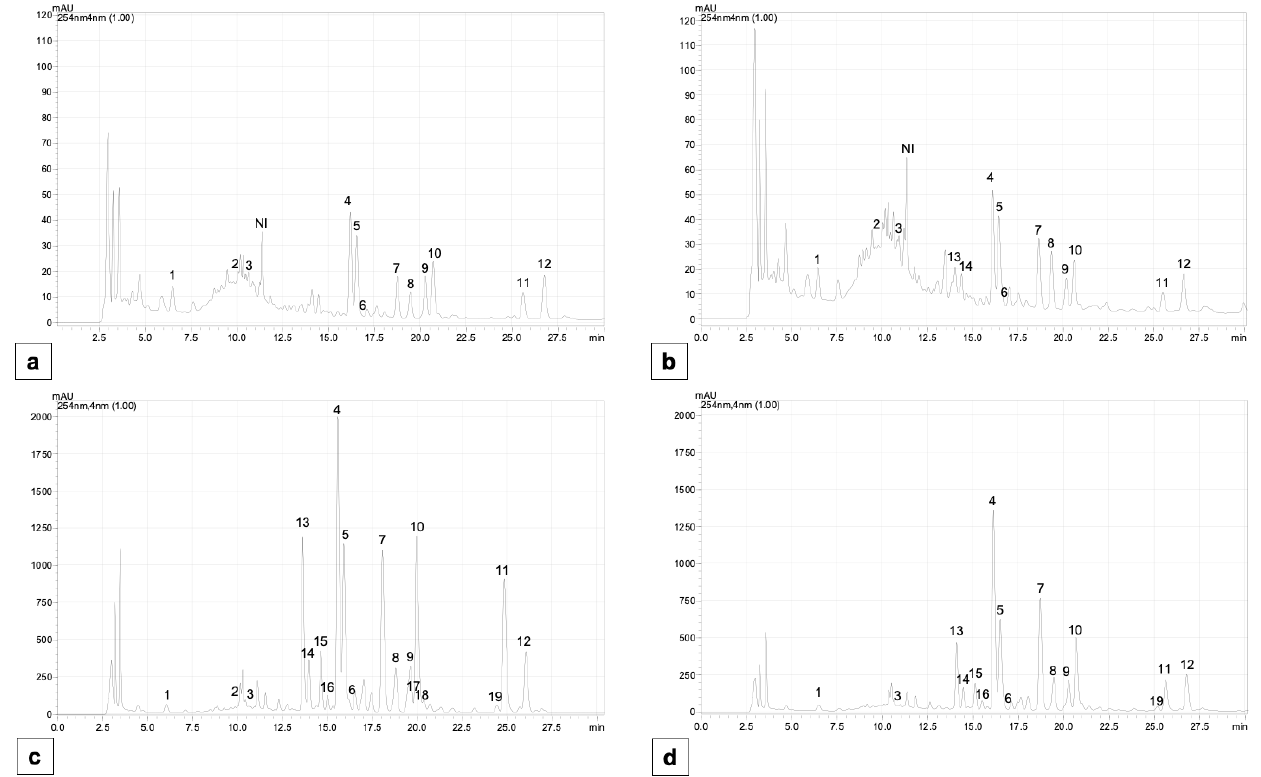
Figure A2. Chromatographic profile of the phenolic acids and flavonoids at 254 nm for different parts of the Glaux maritima : roots in slight ( a ) and strong ( b ) soil salinity, shoots in slight ( c ) and strong ( d ) soil salinity. 1—3,4-dihydroxybenzoic acid; 2—catechin; 3—chlorogenic acid; 4—quercetin derivative; 5—kaempferol derivative; 6—ferulic acid; 7, 8—kaempferol derivative; 9—quercetin derivative; 10— quercetin 3- β - D -glucoside; 11, 12, 13—quercetin derivative; 14—p-coumaric acid; 15, 16—quercetin derivative; 17—hyperoside; 18—quercetin 3-O-rutinoside; 19—kaempferol 3-O-glucoside; NI—not identified.